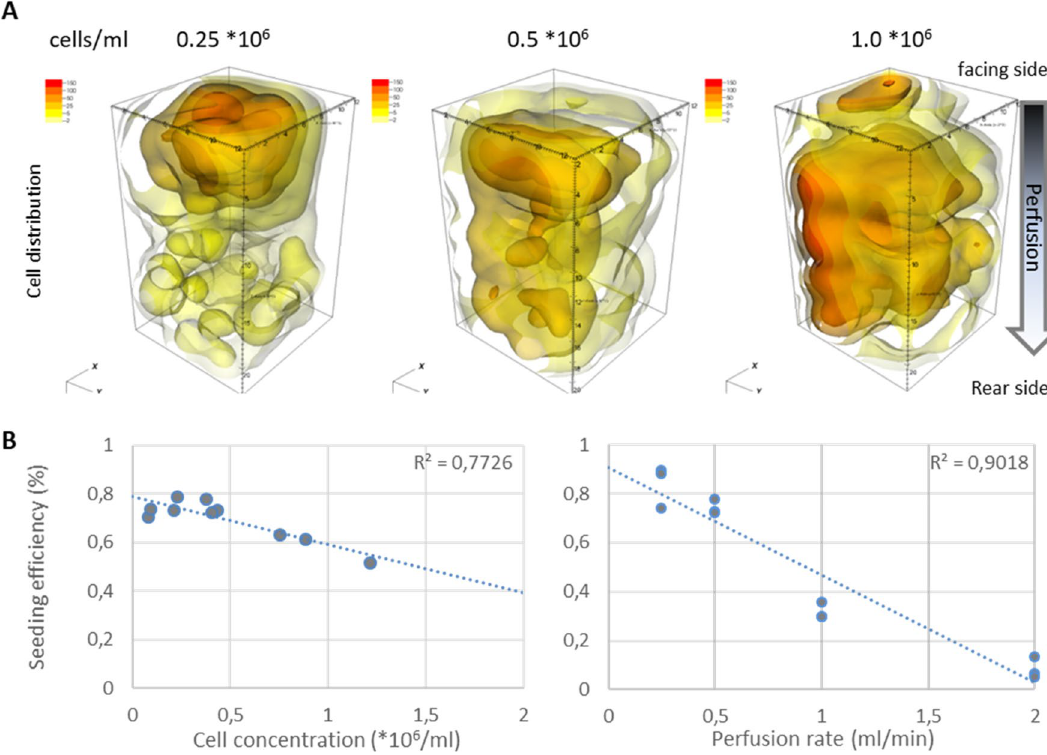
Figure 5. Influence of cell concentrations and perfusion rates on the cell distribution and homogeneity using bioreactor type2_enc+. ( A ) 3D reconstruction of perfused scaffold blocks using cell concentrations between 0.25 to 1.0 × 10 6 cells/ml. Obviously, cells tend to accumulate in the upper half of the scaffold by using unidirectional perfusion. ( B ) Calculation of the cell seeding efficiency in dependence of the cell concentration (left, n = 3) and the perfusion rate (right, n = 3). Finally, low perfusion rates and moderate cell concentrations result in more efficient cell seeding of the